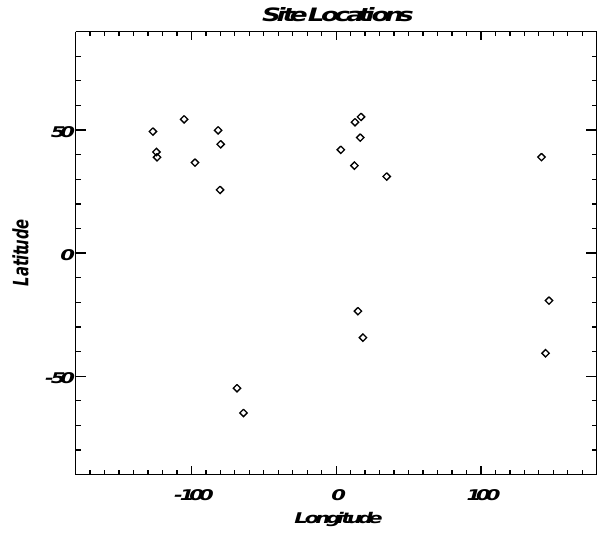
Figure C1. Coordinates of the surface data used in the comparison shown in Fig.